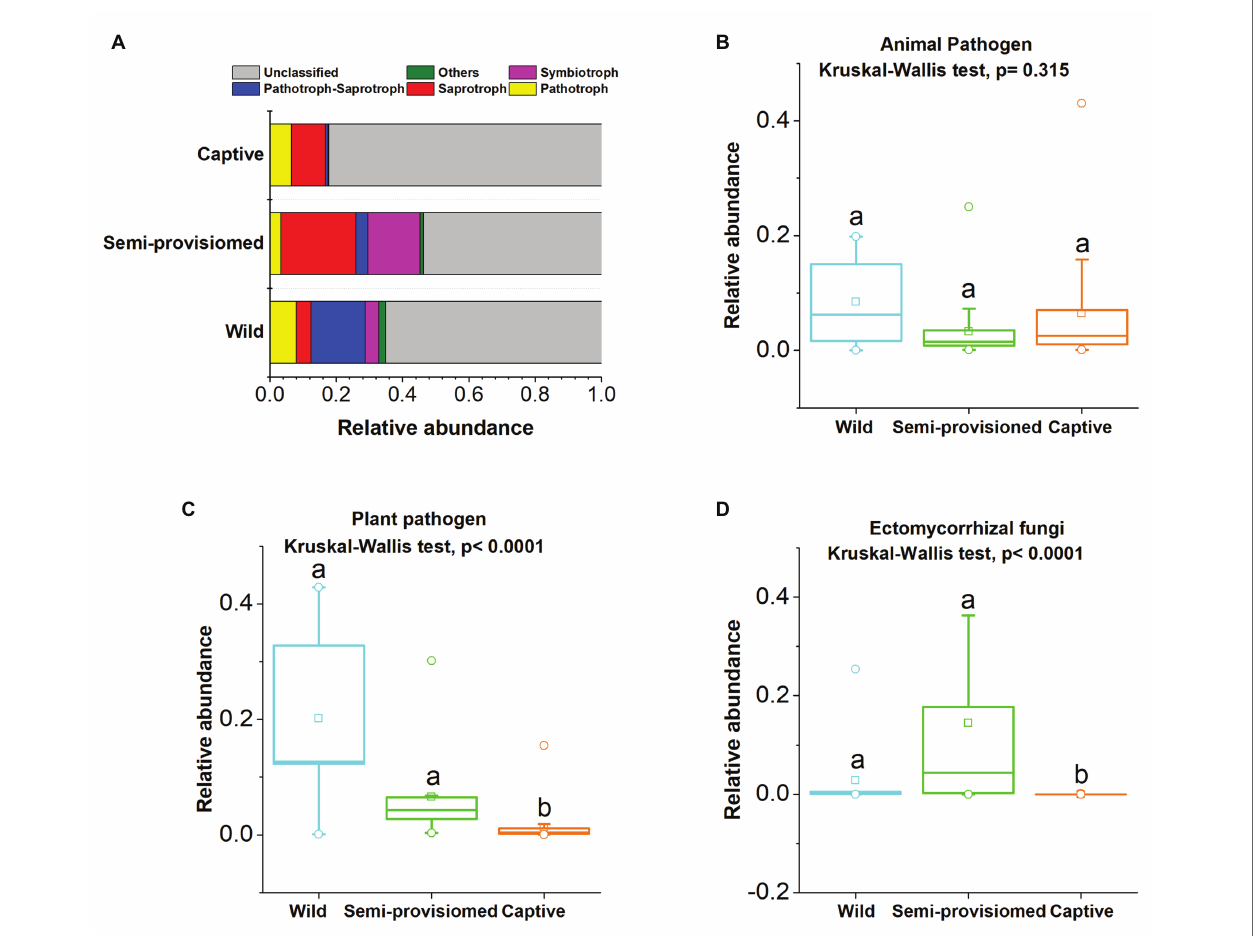
FIGURE 4 | Variation of fecal fungal functional trophic modes across three study groups. (A) Relative abundance of functional trophic modes. Stacked bar graphs illustrate the abundances, x -axis represents the sample types. (B – D) Comparison of the functional guilds of animal pathogens, plant pathogens, and ectomycorrhizal fungi, respectively. A Kruskal-Wallis ANOVA test was used to evaluate the variation across treatment groups. Post hoc tests (Dunn’s test) for pairwise comparison tests (values of p were adjusted by Bonferroni). Significance was set at the 0.05